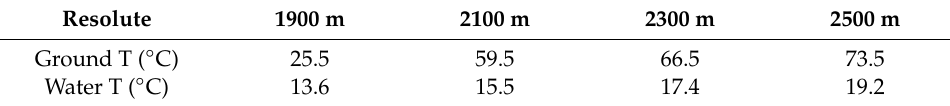
Table 8. Resolute ground and water temperature at